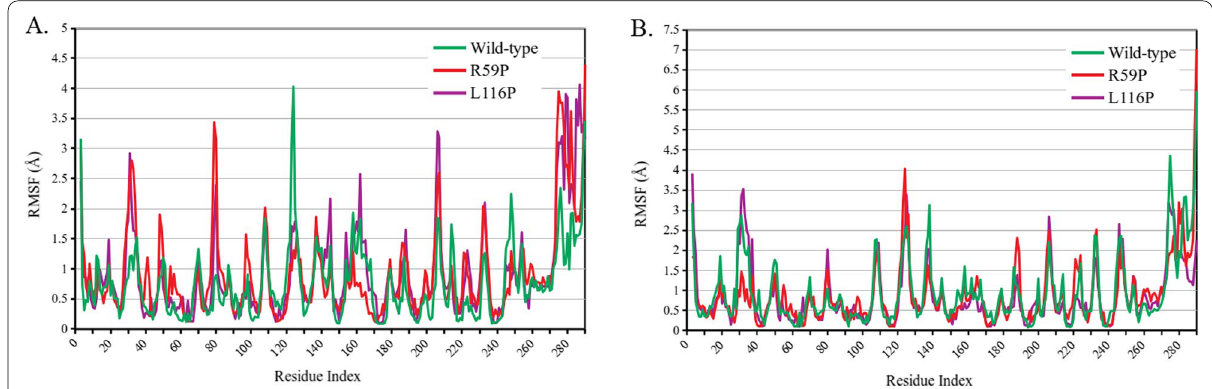
Fig. 2 Fluctuation profiles of the wild-type and two variant (R59P and L116P) structures of pirin. A comparison between the predicted residue fluctuation profiles of the wild-type and the variant structures in case of Fe 2 + ( A ) and Fe 3 + ( B ) conformations of pirin is graphically presented. RMSF denoting root mean square fluctuation in Å is displayed in the y-axis and pirin residues are displayed in the x-axis